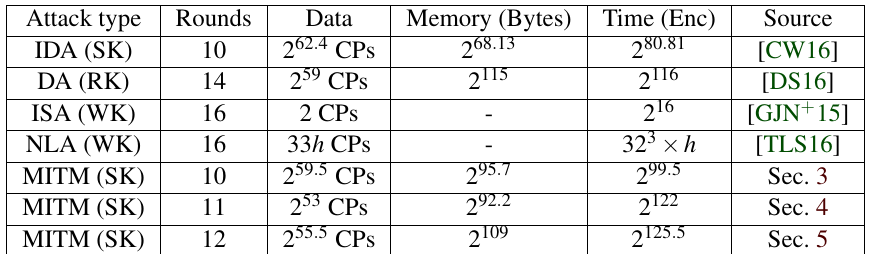
Table 1: Summary of the best attacks on